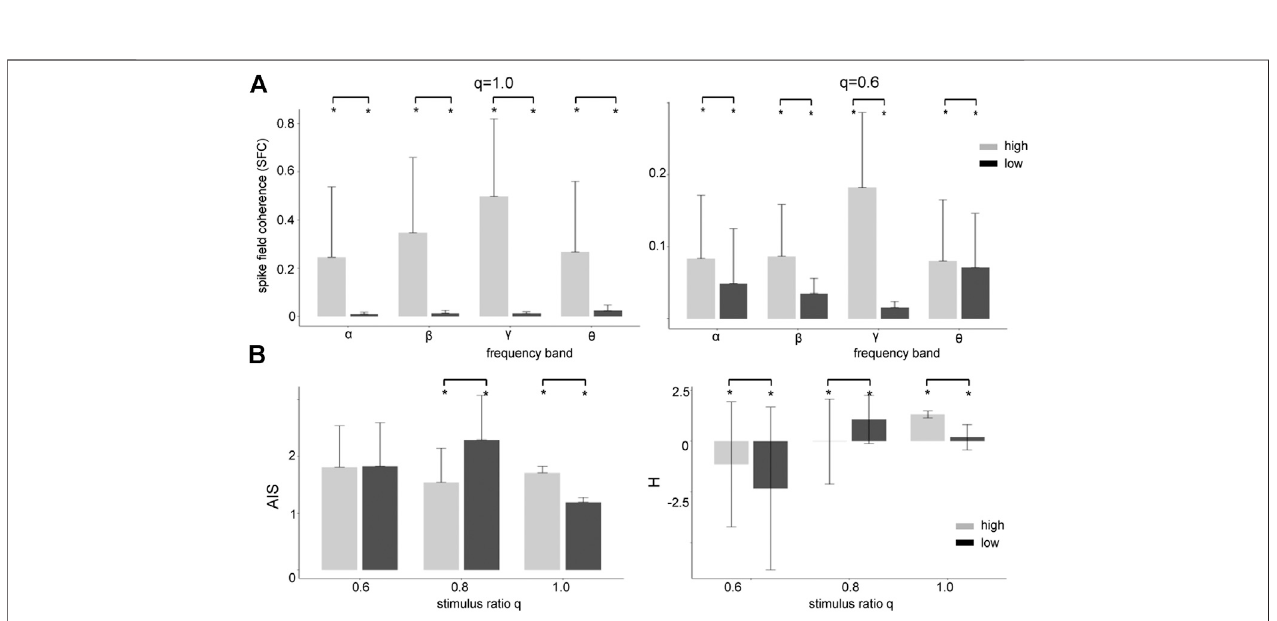
FIGURE 6 | High zero-mean Gaussian noise enhances the Spike Field Coherence in all frequency bands and affects heterogeneously Active Information Storage (AIS) and differential entropy (H). (A) The differences between high noise intensity (grey-colored) and low noise intensity (black-colored) is signi fi cant ( p < 0 . 001 ) for both global and partial stimulation. (B) For global stimulation ( q (cid:1) 1 . 0 ) , high noise intensity induces states of signi fi cantly enhanced stored active information (AIS) and available information (H), whereas partial stimulation with q (cid:1) 0 . 8 diminishes both AIS and H signi fi cantly. Results for q (cid:1) 0 . 6 are not consistent and dif fi cult to interpret. In all panels, vertical bars denote the standard deviation, p < 0 . 001 and parameters are identical to the parameters used in Figure 5 .